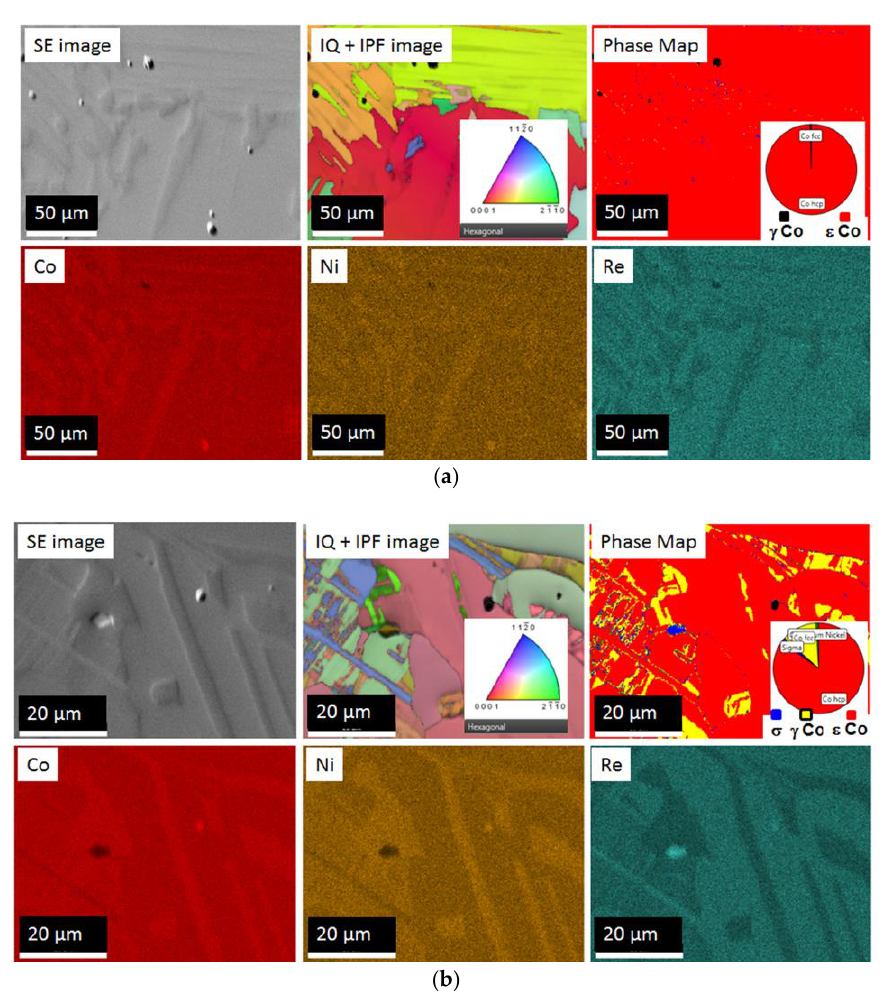
Figure 6. Combined EBSD + EDS measurement: ( a ) CoRe18-8 alloy after 1200 °C heat treatment; ( b ) CoRe-18-15 alloy after1050 °C heat treatment.